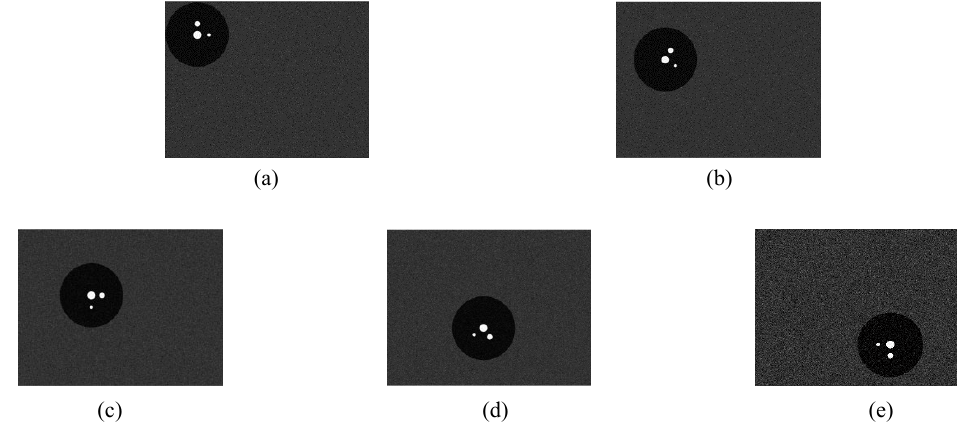
Fig.8 Experimental results at each step: (a) original image, (b) binary process, (c) circles detection, and (d) centers extraction.